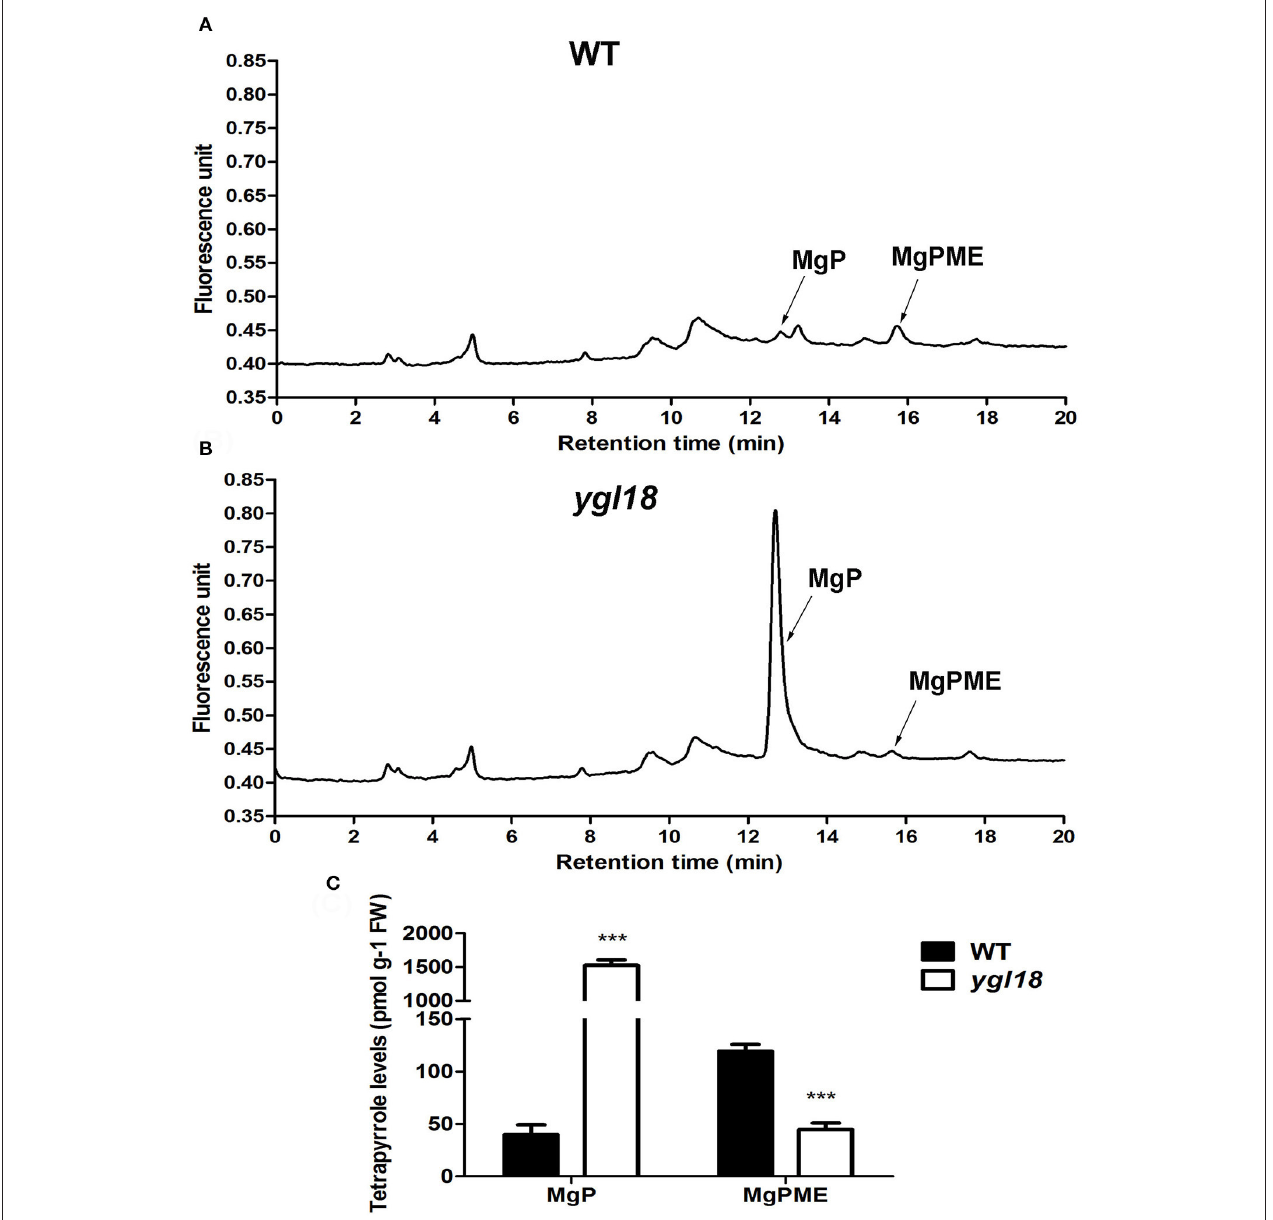
FIGURE 7 | HPLC analysis of MgP and MgPME contents from the seedling leaves of wild-type and ygl18 plants. (A,B) Representative chromatograms of the extracts from wild-type (A) and ygl18 (B) plants (28 ◦ C, 8h light condition, 150 µ mol m − 2 s − 1 ). The arrows indicate the peak positions of MgP (about 12.7 min) and MgPME (about 15.8 min), which are distinguished by comparing with the standard curve (Figure S3). (C) Quantification of MgP and MgPME contents. FW, fresh weight. Data represent the mean ± SD of three biological replicates (Student’s t -test: *** P < 0.0005). Different letters indicate values are statistically different based on a one-way ANOVA